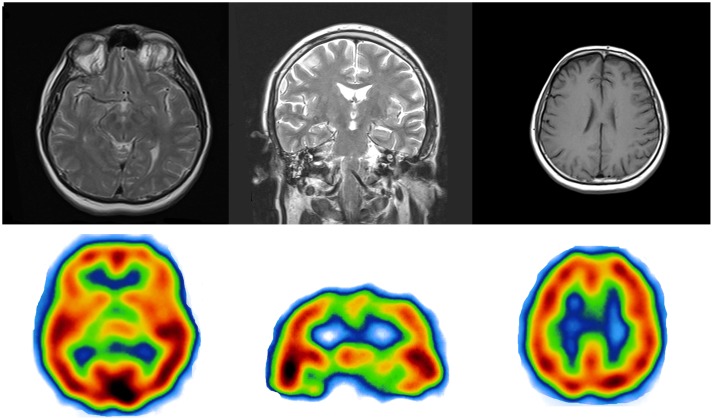
Results of MRI and SPECT examination of a control subject.Magnetic Resonance Imaging and Single Photon Emission Computed Tomography demonstrating the normal scans of a control, age-matched patient with no signs of any neurodegenerative disorder.